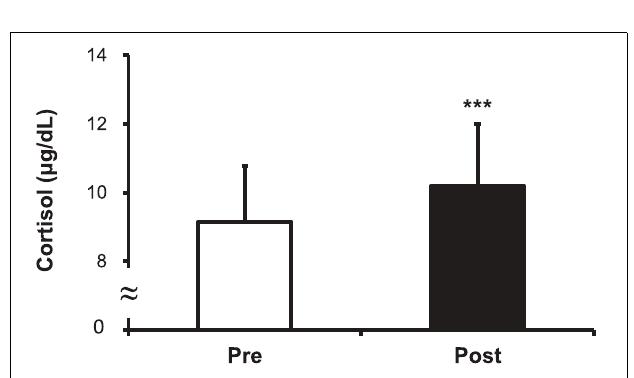
FIGURE 5 | Comparison of serum cortisol concentration before (Pre) and after (Post) hot water bath (42 ± 0.5 ◦ C) immersion. Values are mean ± SD. *** P < 0.001, statistically significant difference between Pre- and Post-exposure values.